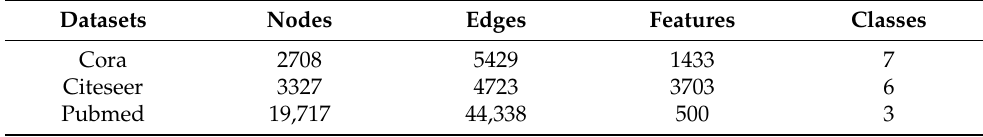
Table 1. The details of